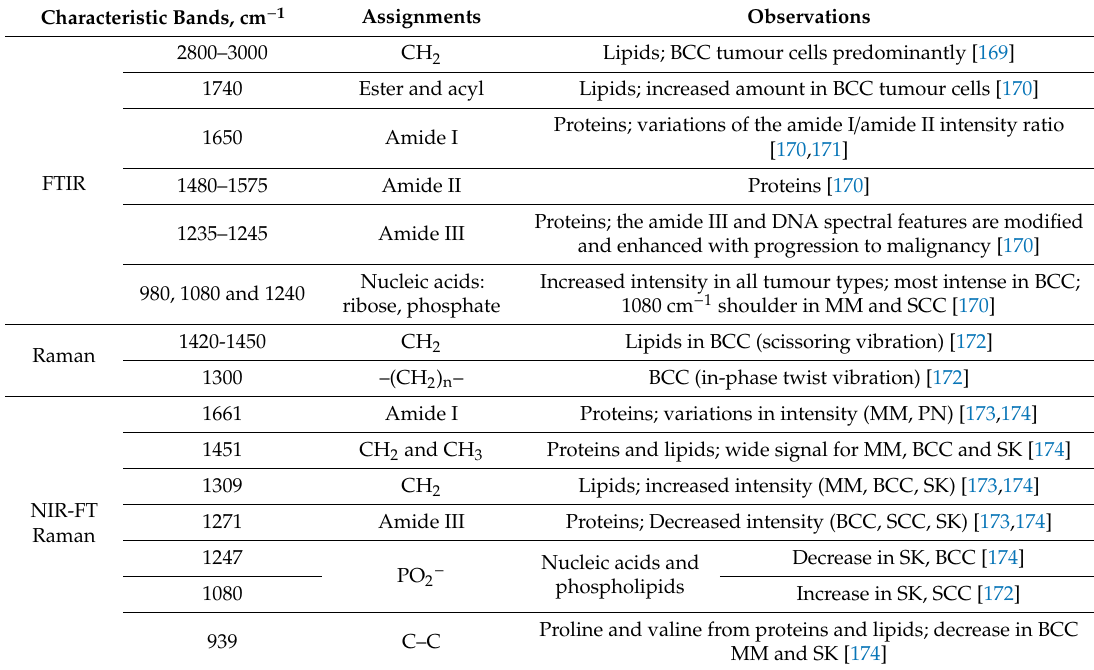
Table 7. The main structural shifts observed in IR and Raman spectra of di ff erent skin lesions. Characteristic Bands, cm −